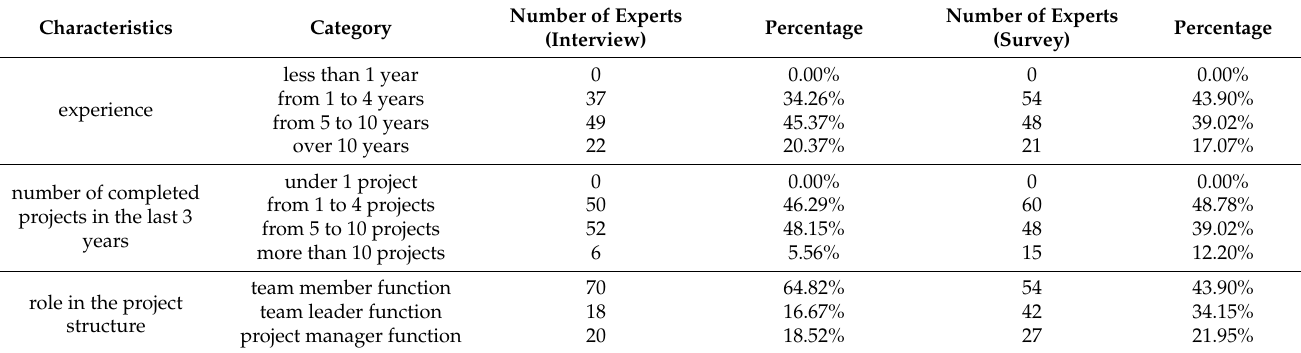
Table 1. Characteristics of the experts participating in the